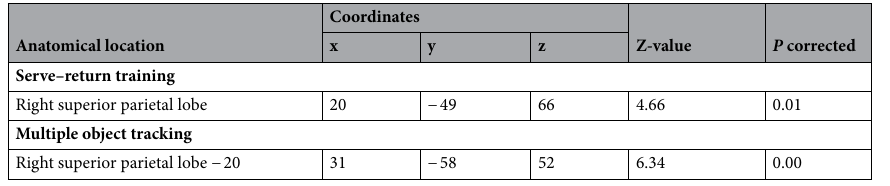
Table 1. Differences in gray matter volume between the individuals with high VR suitability and low VR suitability for each experiment. The coordinates (x, y, z) indicate local maxima in each brain region according to the MNI template.